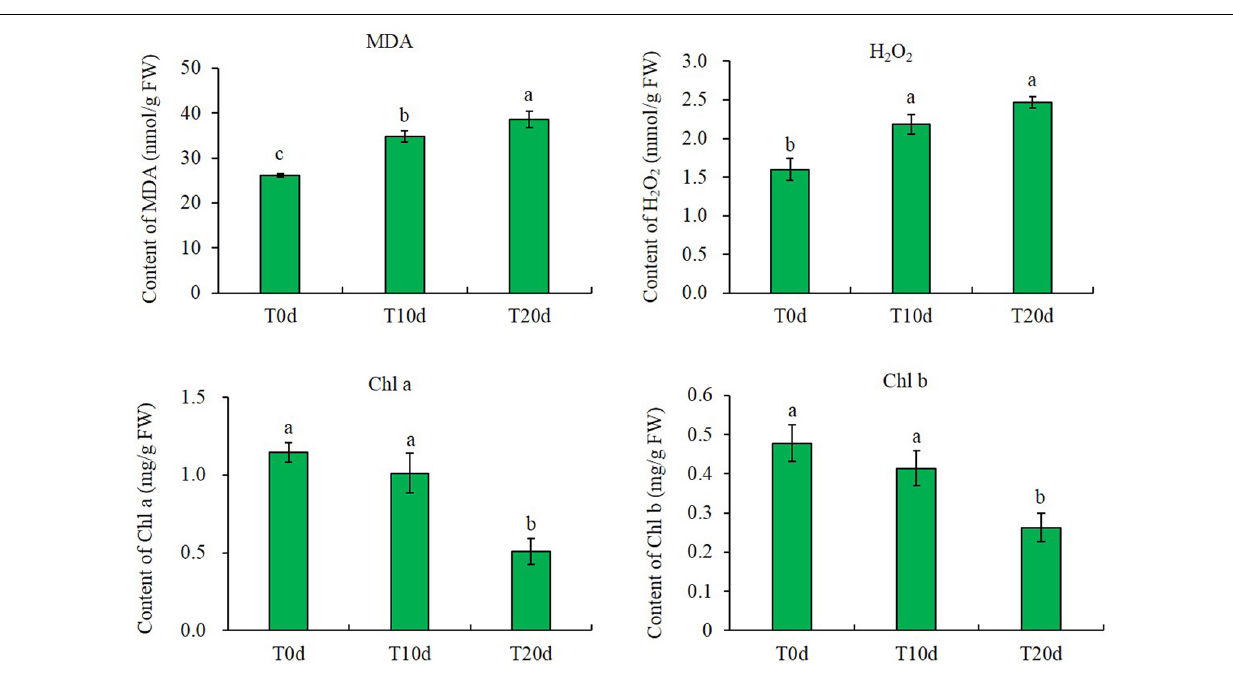
( Figure 3B ). The average molecular mass of the identified gene products ranged from 10 to 70 kDa, and the average mass error was < 0.02 Da, indicating a high mass accuracy of the MS data